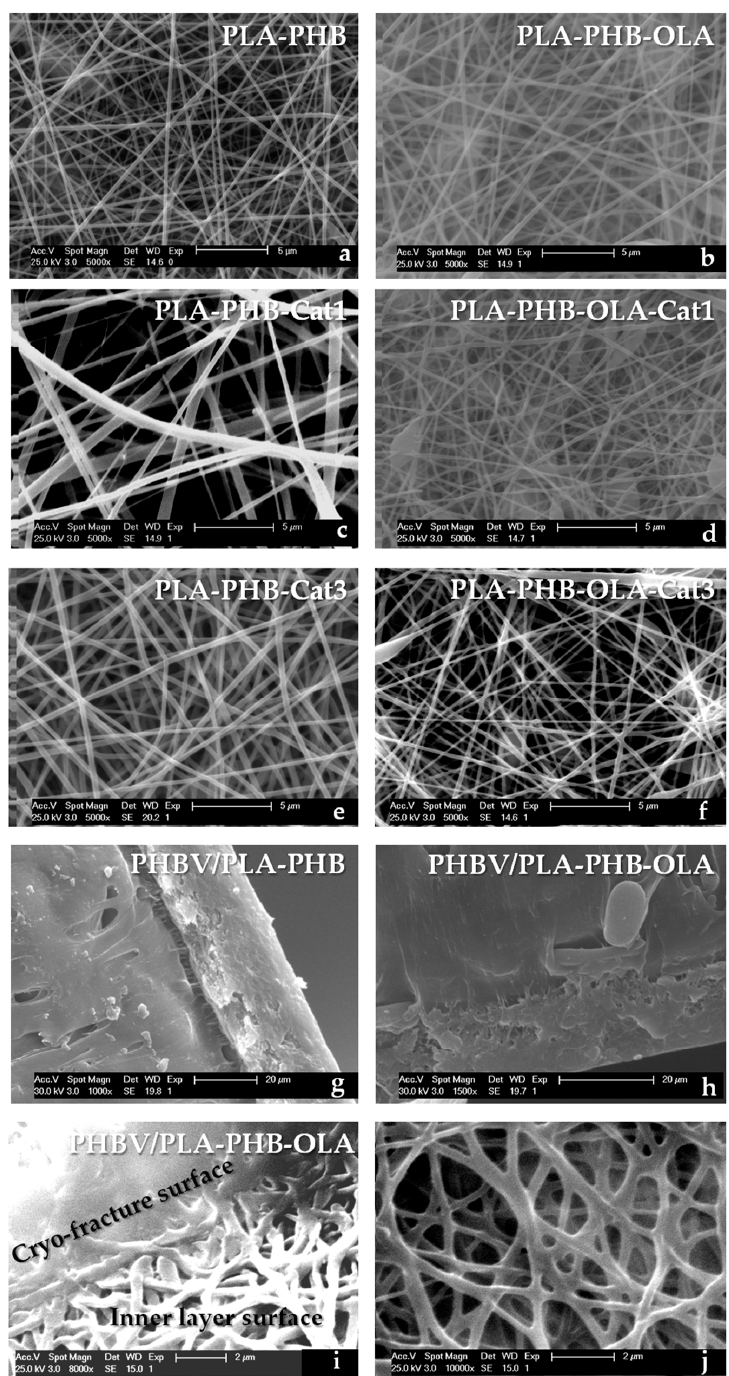
Figure 1. Scanning electron microscope (SEM) observations of electrospun mats: ( a ) PLA-PHB, ( b ) PLA-PHB-OLA, ( c ) PLA-PHB-Cat1, ( d ) PLA-PHB-OLA-Cat1, ( e ) PLA-PHB-Cat3, and ( f ) PLA-PHB- OLA-Cat3; SEM observations of the cry-fracture section of ( g ) PHBV/PLA-PHB and ( h ) PHBV/PLA- PHB-OLA as well as ( i , j ) inner surface of PHBV/PLA-PHB-OLA.